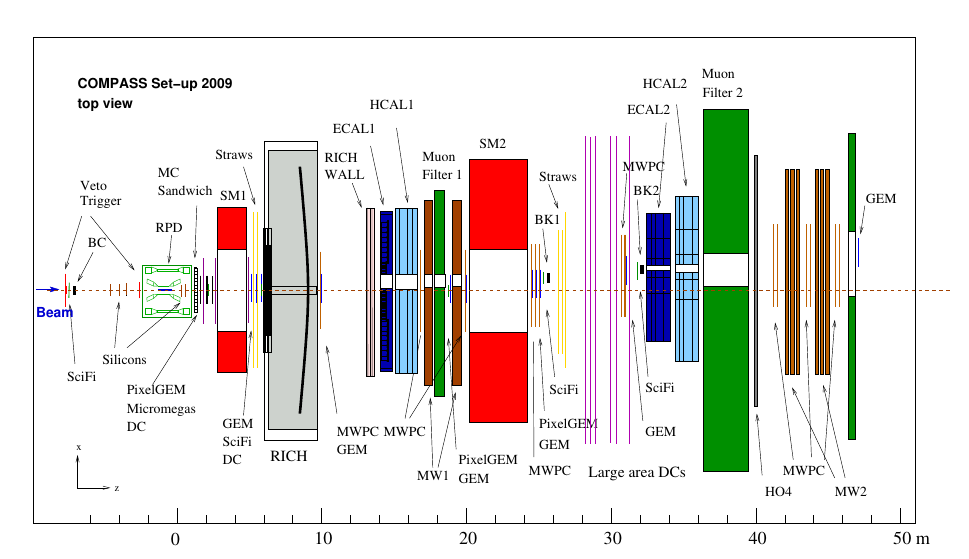
Figure 1. Layout of the COMPASS setup as used for hadron beams in the years 2008 and 2009. A detailed description of the employed detectors can be found in [7]. The spectrometer magnets SM1 and SM2, equipped up- and downstream with tracking detectors and followed by calorimeters, constitute the two stages of the